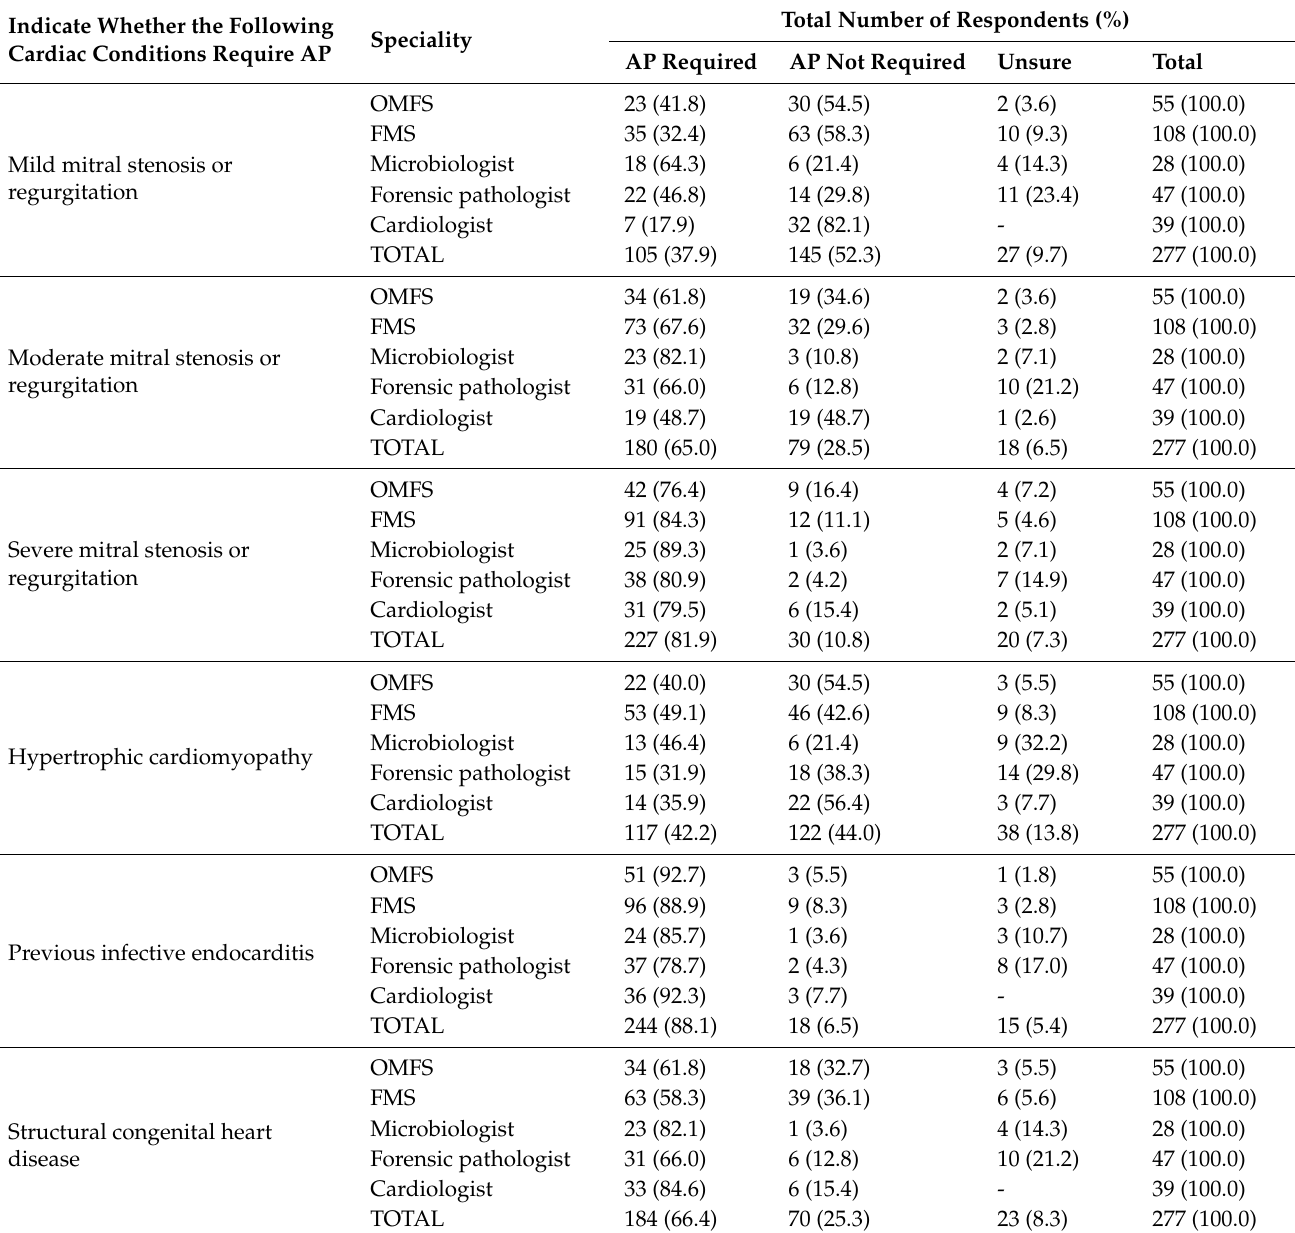
Table 7. Requirement of AP prior to invasive dental procedures in selected cardiac